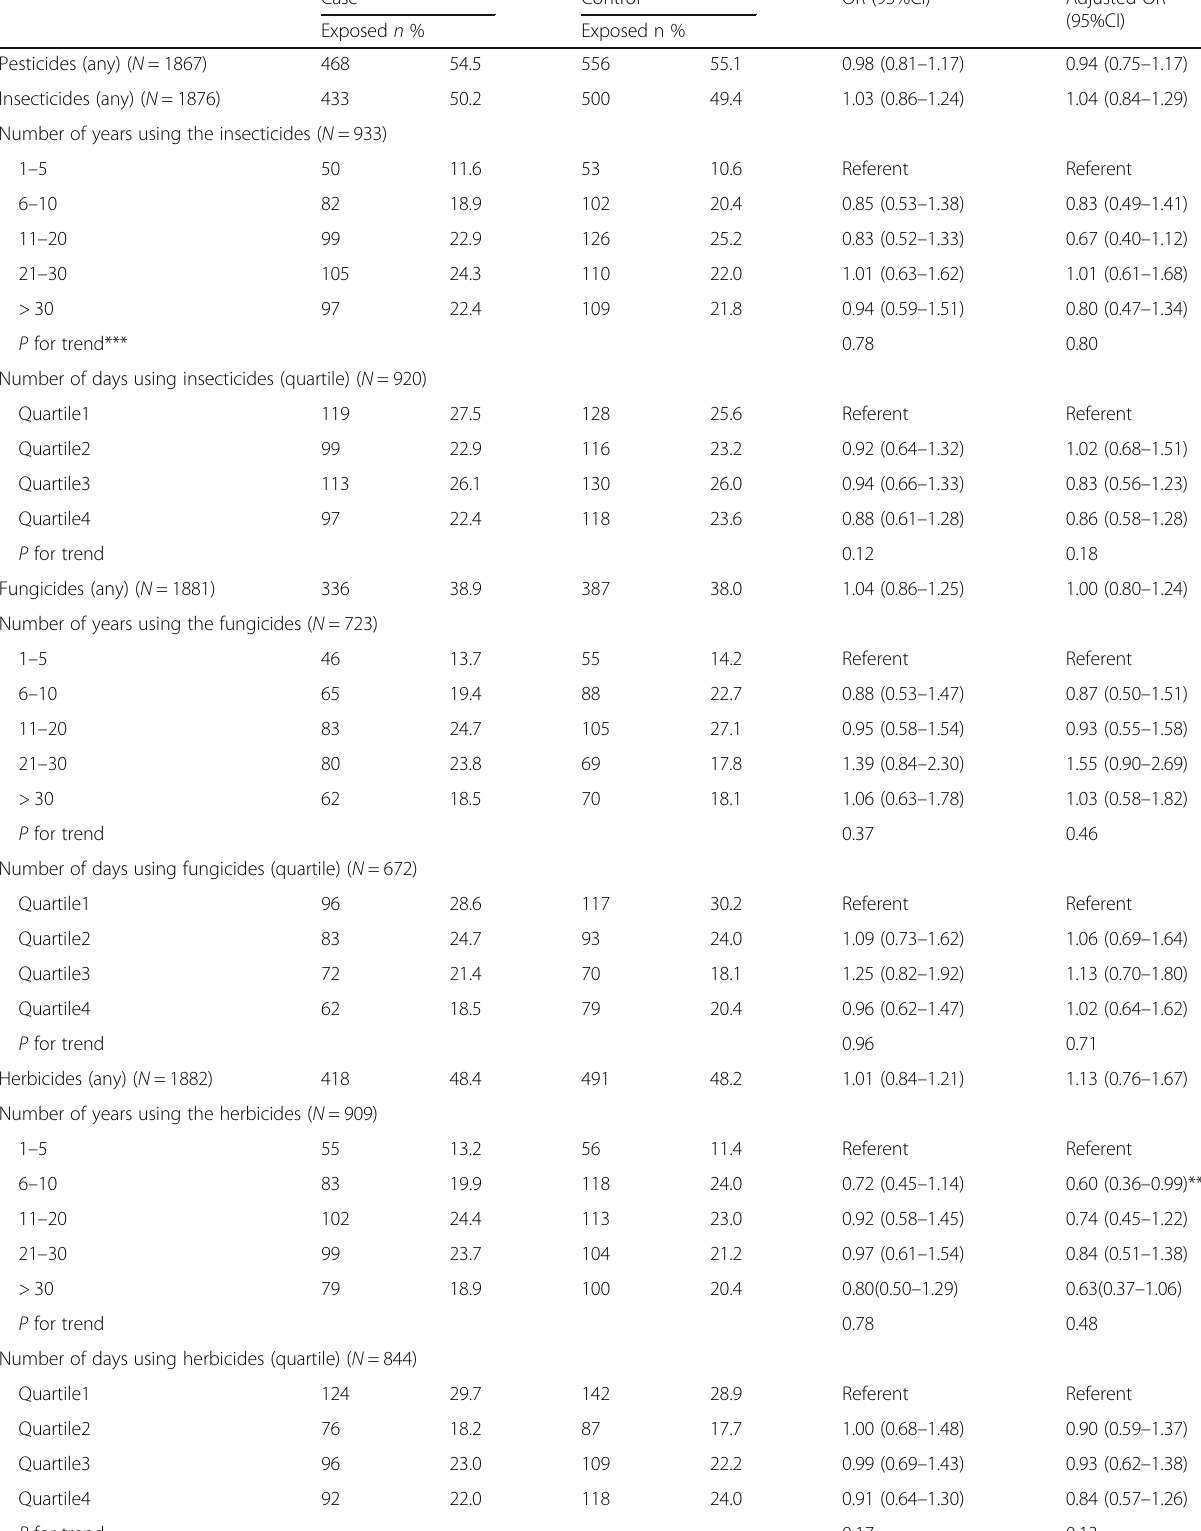
Table 2 Associations between different types of pesticides and